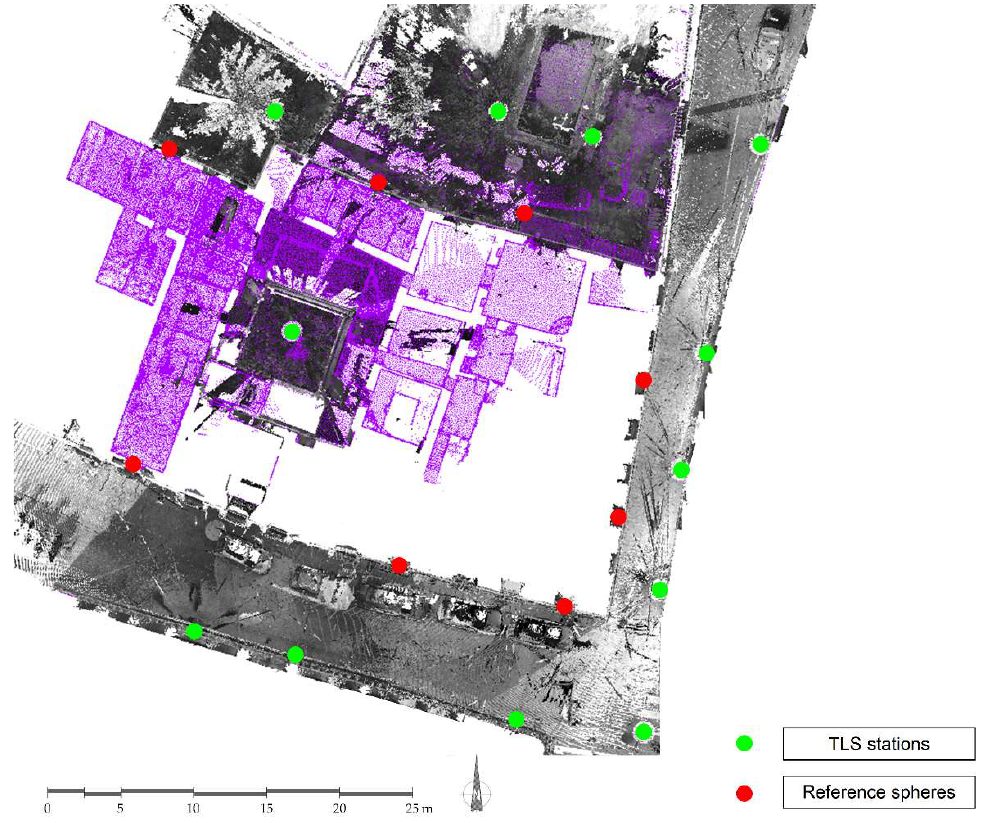
Figure 12. Reference sphere distribution on the first floor for the path 2 (red circles) and the outdoor TLS network (green circles). Scans coming from the terrestrial laser scanner are outlined in the grey color, whereas scans coming from the WMLS for the path 2 are represented in the purple color.